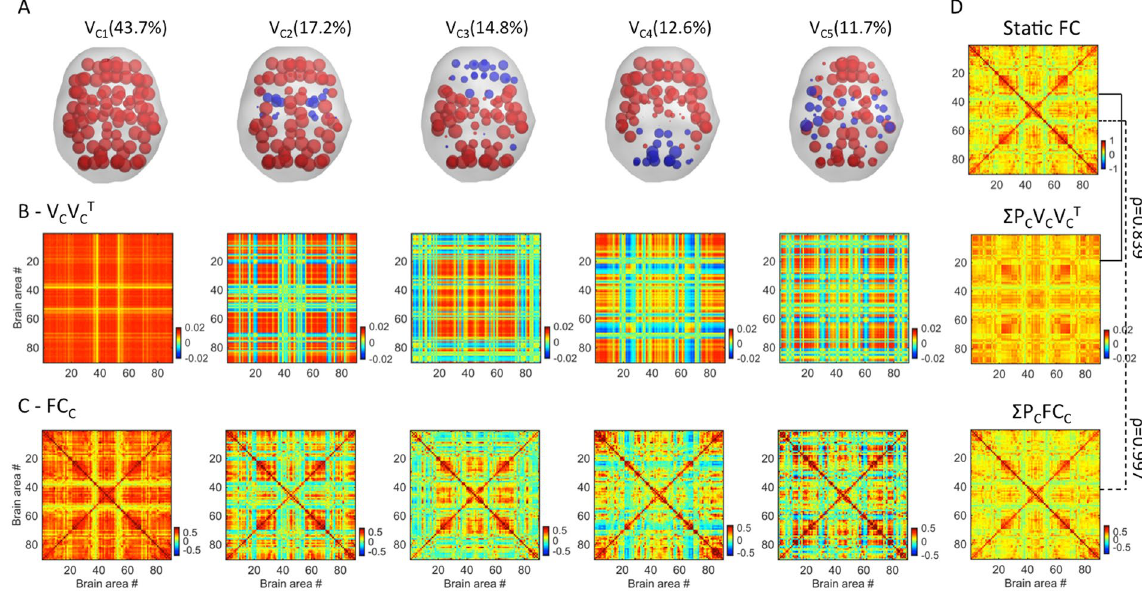
Figure 3. FC states and comparison with Static FC. Five recurrent FC patterns, or states, were obtained from clustering the leading eigenvectors of the dFC s of all participants. ( A ) Each of the five FC patterns is represented by a vector V C , where V C (n) weighs the contribution of each brain area n to that pattern (displayed in cortical space). Elements with the same sign in V C are colored alike to illustrate the network partition captured by V C (see Methods - FC Leading Eigenvector ). States are ranked according to their probability of occurrence (P C , in %). ( B ) V C V CT illustrates the NxN connectivity pattern corresponding to each state. ( C ) dFC averaged over the time points of each state. ( D ) The static FC averaged over all subjects (top) correlates strongly ( r = 0.839) with the weighted sum of the five connectivity patterns captured by V C V CT (middle). The correlation increases up to r = 0.997 when considering the weighted sum of the dFC averaged over the time points of each state